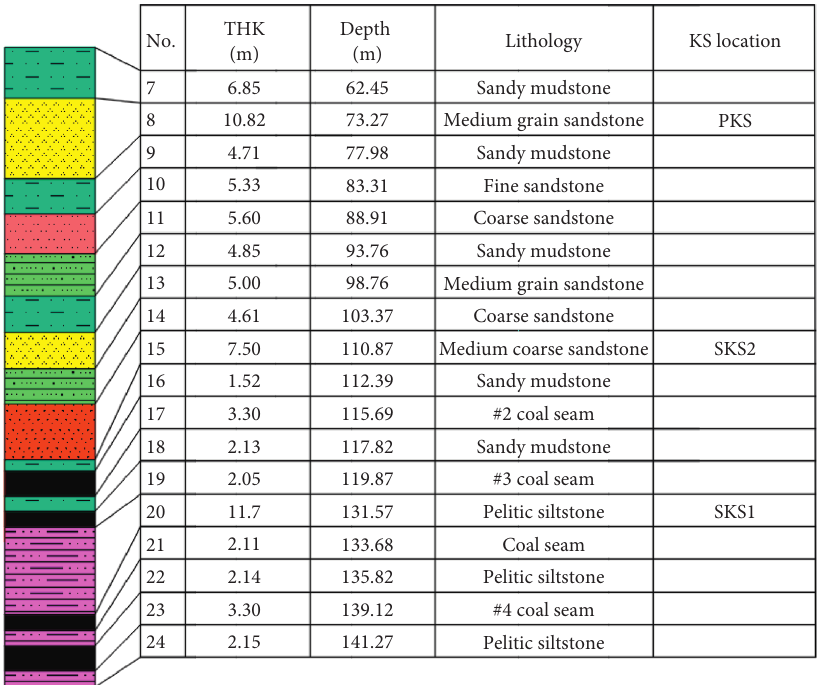
Figure 9: Bore hole columnar section of the coal strata in the Fengjiata coal mine. Table 2: Physical and mechanical parameters of the coal strata in the Fengjiata coal mine. Rock